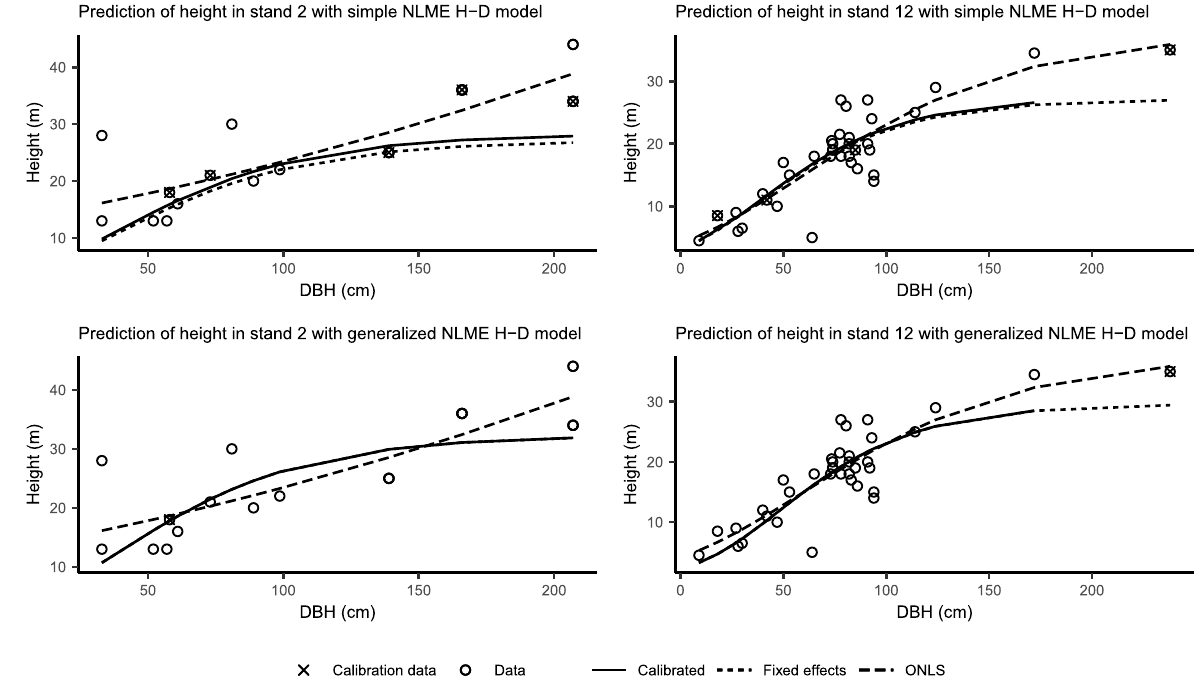
Fig. 6 Example of the calibration of simple NLME model with five sample trees and generalized NLME model with one sample tree in stands 2 and 12 compared to the fixed effects and ONLS prediction with simple H–D model and generalized H–D model of A. araucana . The ONLS fits of generalized H–D model did not converge in either stand. Therefore, the generalized NLME model was likewise compared with the ONLS prediction of the simple H–D